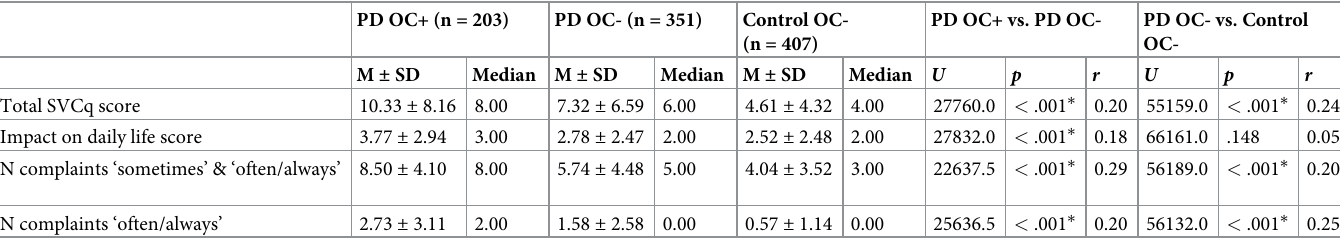
Table 5. SVCq scores of people with and without an ophthalmological condition, with Mann-Whitney U test